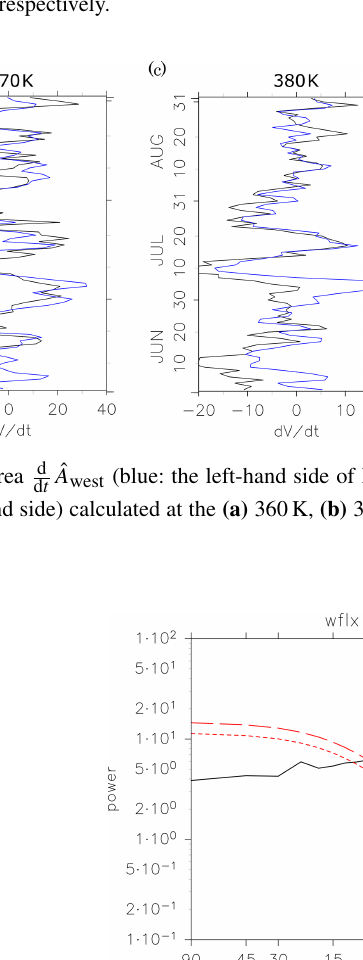
Figure 4. Time–longitude cross section of the air inside the AMA, defined based on the isentropic PV map at the (a) 360K, (b) 370K, and (c) 380K levels. Color shadings show the thickness-weighted low-PV area (10 12 kgK − 1 ) calculated for each longitude grid (1.5 ◦ resolution). Black solid and blue dashed contours respectively show the positive and negative zonal flux of thickness-weighted low-PV area. The contour interval is 4.0, 1.5, and 1 . 0 × 10 7 kgK − 1 s − 1 in panels (a) , (b) , and (c) , respectively.